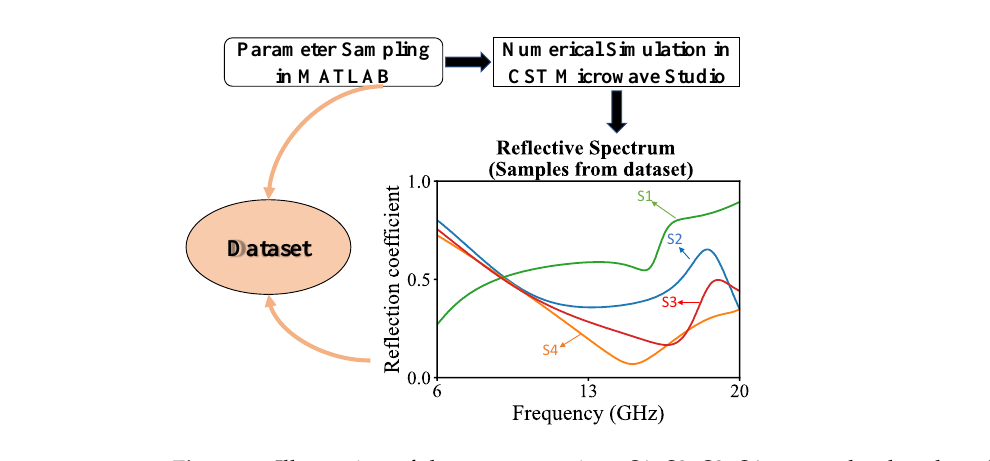
Figure 4. Illustration of dataset generation. S1, S2, S3, S4 are randomly selected sample spectra from dataset. Table 1. Design parameters sampling